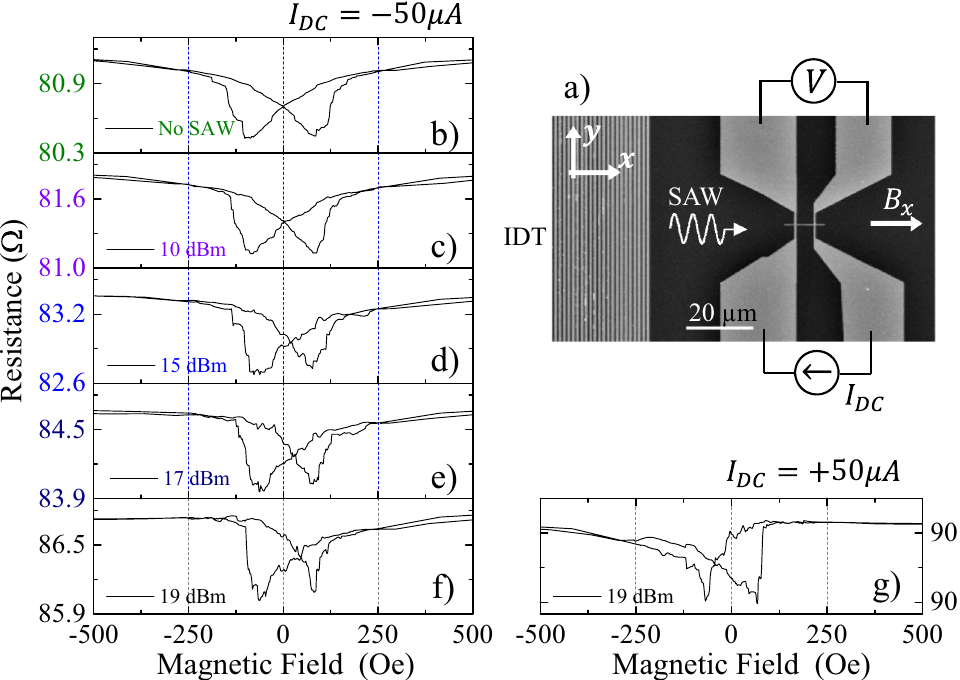
Figure 1. ( a ) SEM photograph of the experimental device, with a IDT to excite the Surface Acoustic Waves (vertical lines visible on the left hand side of the picture) and a ferromagnetic nanostrip aligned with the direction of the travelling SAW. ( b ) to ( f ) AMR loops for different SAW powers showing an increasing asymmetry as the power of the SAW increases. ( g ) Same experiment as in ( f ) but reversing the direction of the measuring DC